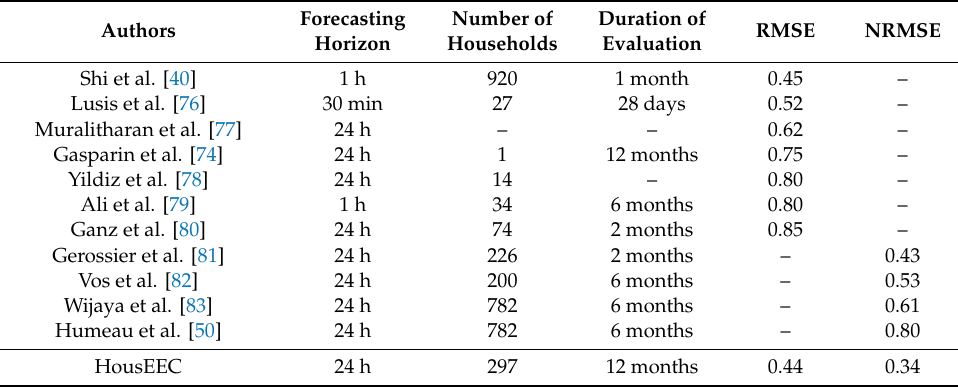
Table 5. Summary of state-of-the-art STLF